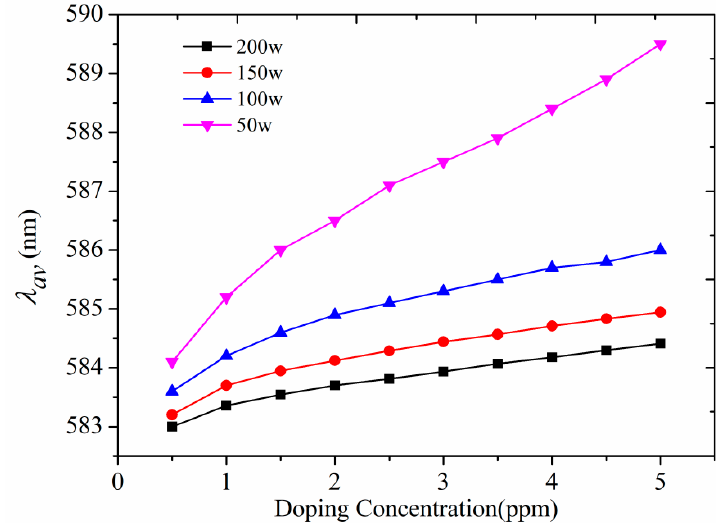
Figure 13. The average wavelength λ av as a function of the QDs doping concentrations.